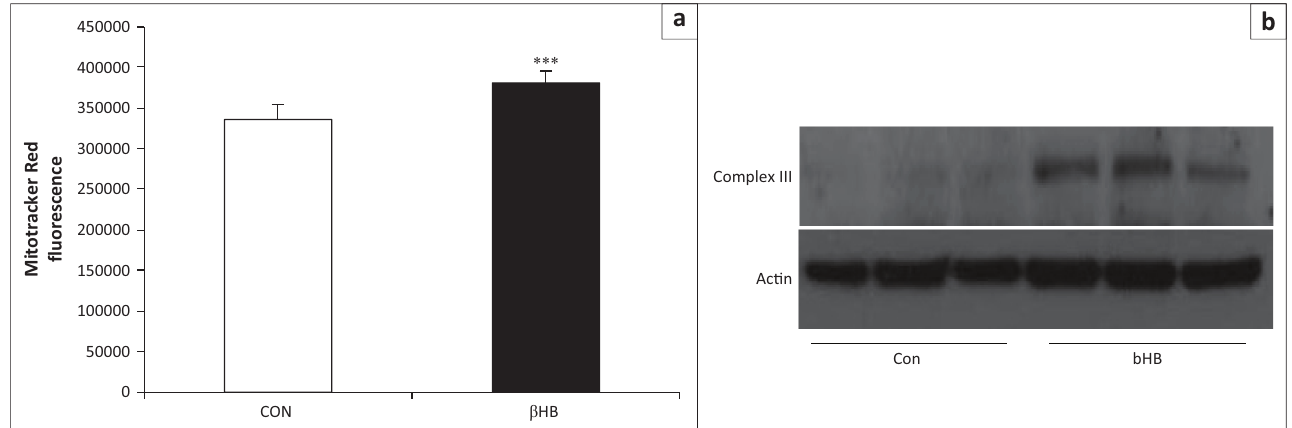
FIGURE 2: β -Hydroxybutyrate increases mitochondrial content and function. INS-1 832/13 β -cells were treated with vehicle (water; CON) or with β -Hydroxybutyrate ( β HB; 10 mM) for 24 h then incubated with MitoTracker and florescence was measured by plate reader assay (a; n = 6). In parallel, cells were used to detect mitochondrial complex III expression via Western blot (b; n = 3). *** P < 0.001 for β HB versus